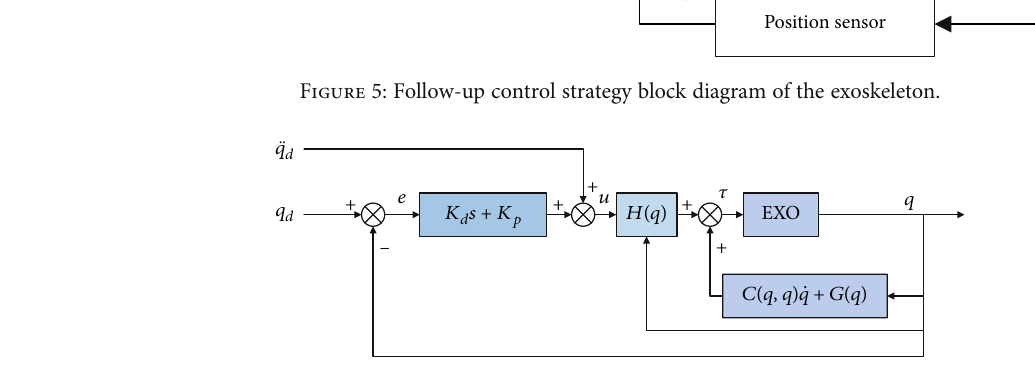
Figure 6: Control block diagram of calculate torque